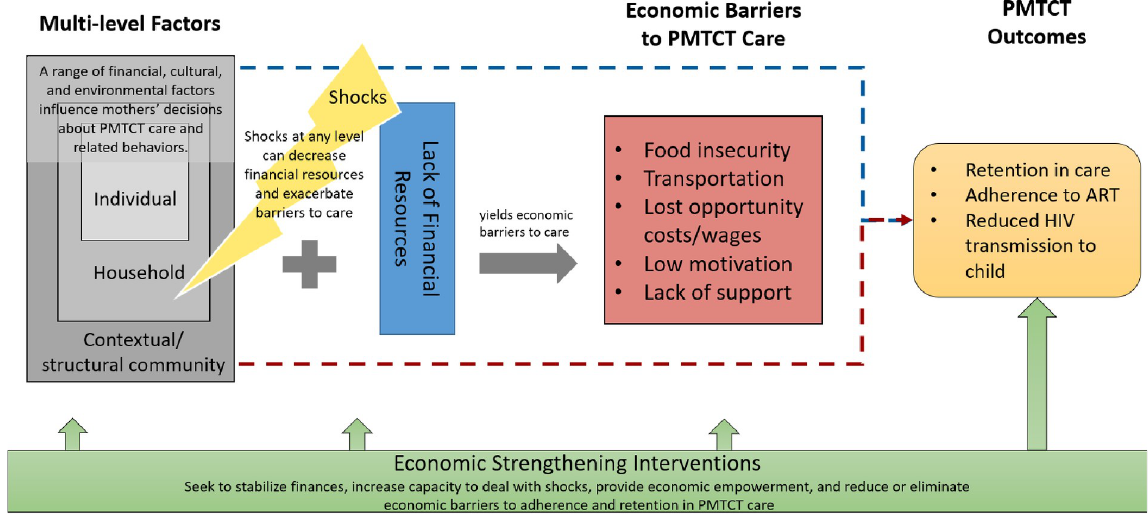
Fig 1. Conceptual model of economic barriers to PMTCT outcomes and the role of economic strengthening interventions.